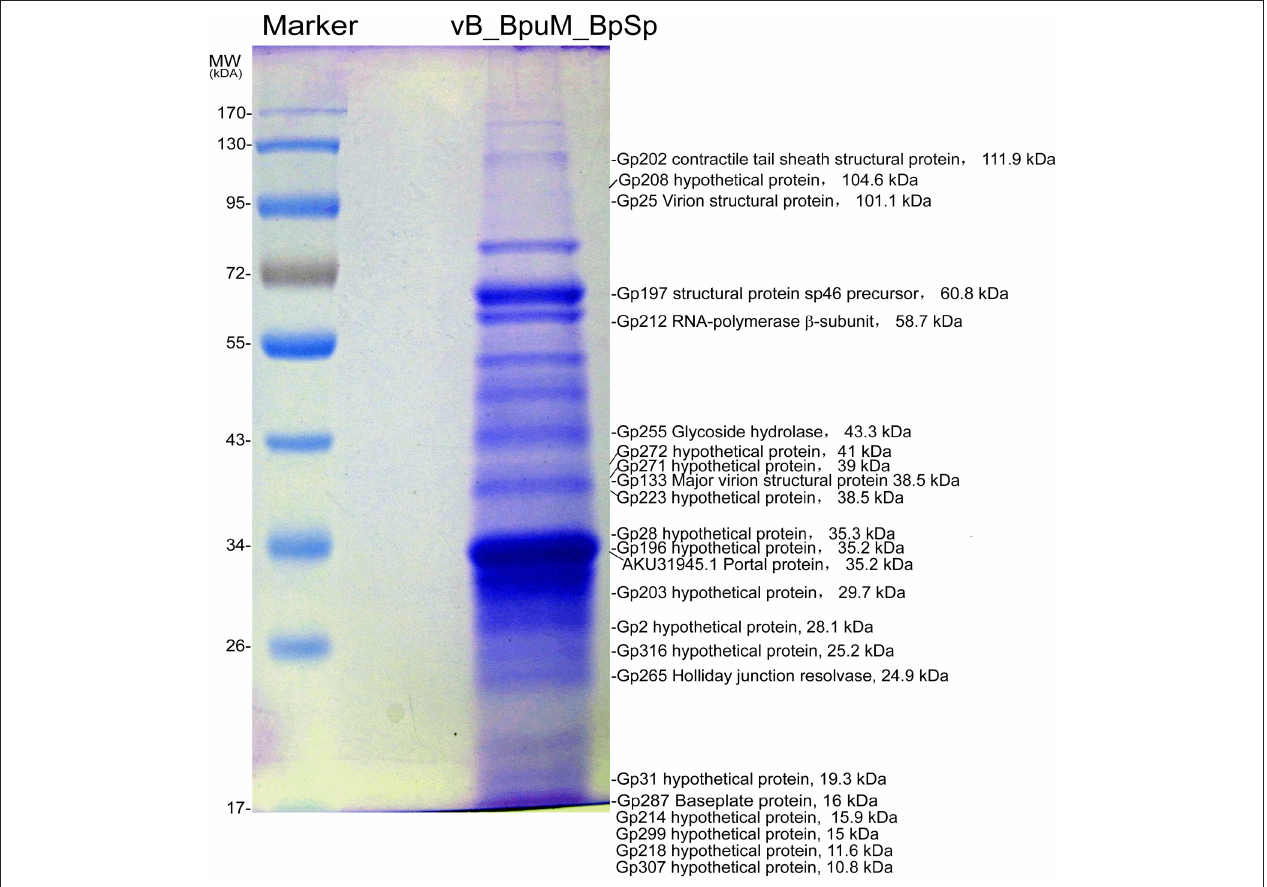
FIGURE 1 | Proteomic analysis of the structural proteins of phage vB_BpuM_BpSp. The phage purified by sucrose density gradient centrifugation was analyzed by SDS-PAGE and the protein bands were further identified by HPLC-MS/MS. The molecular weight standard is indicated on the left. The corresponding CDSs, the predicted functions, and the predicted molecular mass of the proteins identified by mass spectrometry were also